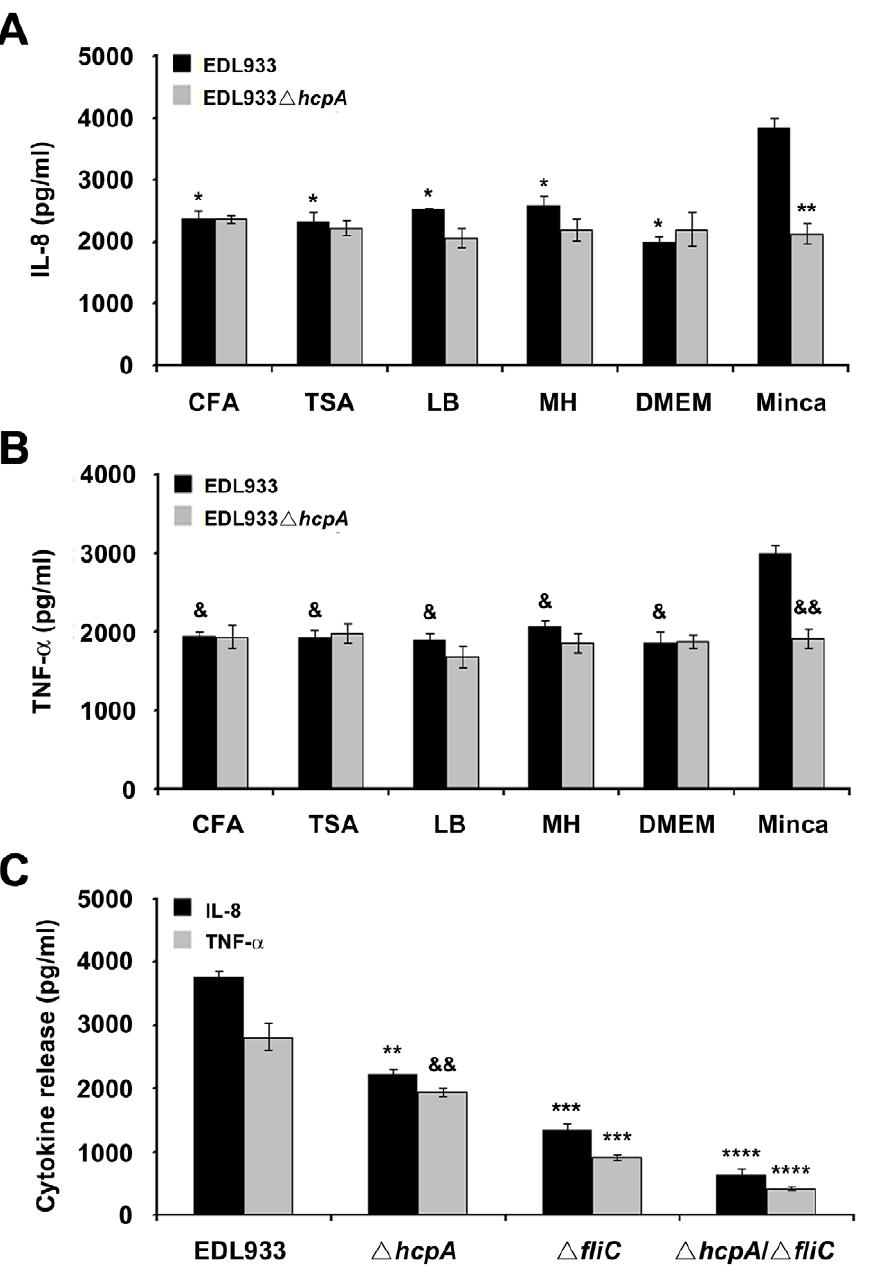
Figure 8. Comparison of the IL-8 release induced by EDL933 and derivative mutants after growth in different media. The highest level of IL-8 and TNF- a release was observed after growth of EDL933 in Minca (A and B) (* P , 0.0001). The hcpA mutant was reduced for IL-8 and TNF- a induction compared to the wild-type strain (** P , 0.0012). Comparison of IL-8 and TNF- a induction by EDL933, EDL933 D hcpA , EDL933 D fliC and EDL933 D hcpA / D fliC previously cultured in Minca (C). Asterisks and ampersands indicate that a value is significantly different from the value for the mutant in hcpA , fliC and the double mutant hcpA / fliC cultured in Minca, ** P , 0.0012, && P , 0.005, *** P , 0.001, and **** P , 0.0001.